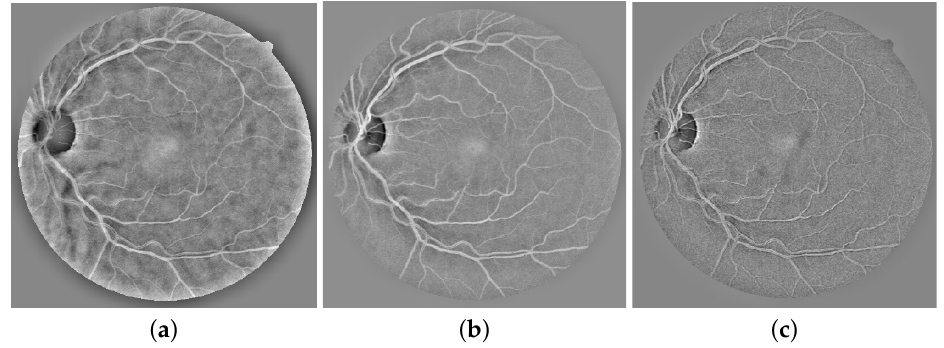
Figure 6. Homomorphic filtering Operation Output ( a ) Homomorphic filtering Output: Red Channel. ( b ) Homomorphic filtering Output: Green Channel. ( c ) Homomorphic filtering Output: Blue